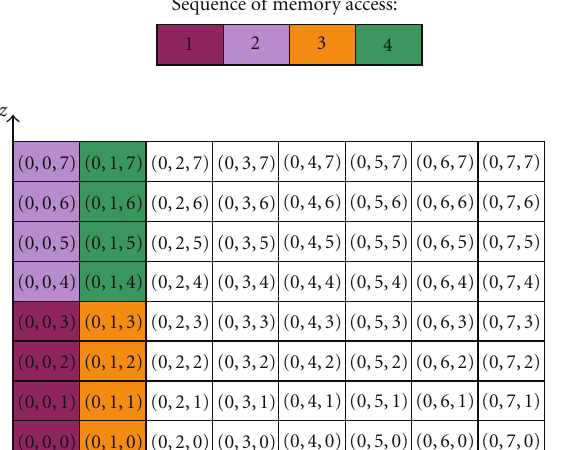
Figure 5: Performance improvement of the parallel conformal FDTD code using VALU acceleration